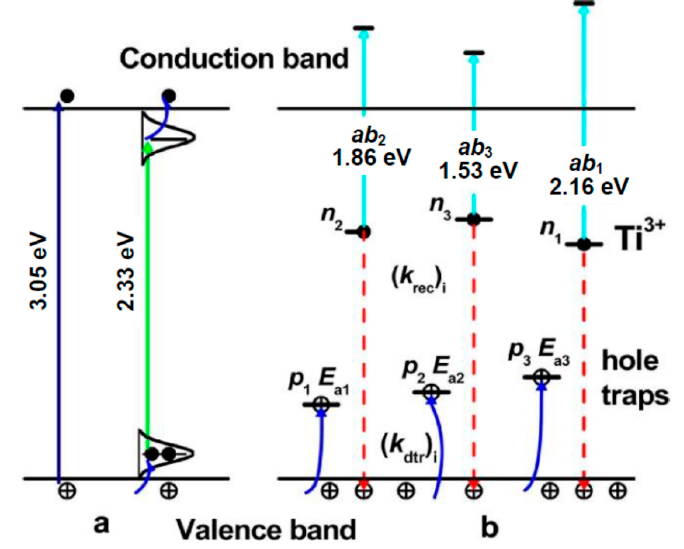
Figure 11. Illustration of the relative positions of the energy levels of: ( a ) F ◦ centers; and ( b ) hole traps and electron traps (e.g., Ti 3+ centers) within the band gap of VLA TiO 2 rutile. The scheme represents a simplistic description of the formation of charge carriers via the intrinsic absorption at 3.05 eV and absorption in the band at 2.33 eV. For simplicity, only three electron and three-hole traps are shown in ( b ). The blue arrows in ( b ) indicate the thermostimulated release of photoholes, while the red arrows indicate the recombination of holes in the valence band with electron Ti 3+ centers; Reproduced with permission from Kuznetsov et al. [68]. Copyright 2014 by the American Chemical